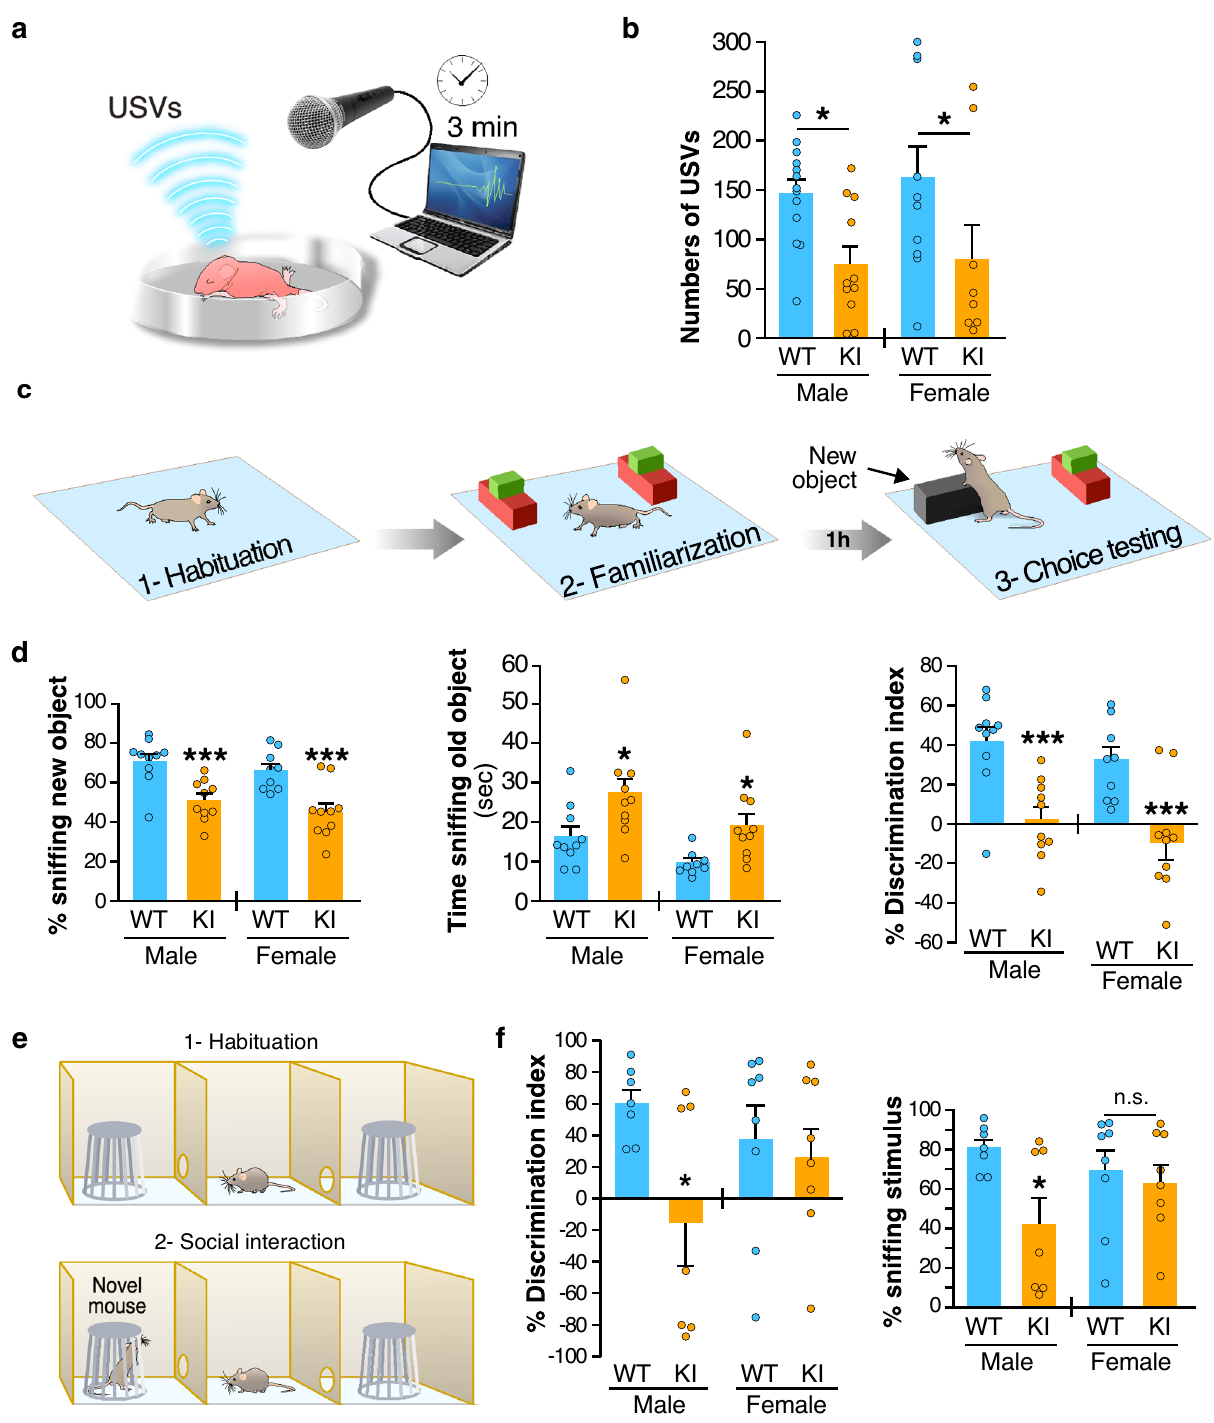
Fig. 6 Fmr1 R138Q mice show communication de fi cits and socio-cognitive alterations. a Schematic of the isolation-induced ultrasonic vocalizations (USVs) test. b Compared to WT animals, Fmr1 R138Q KI mice (PND7) emit ~50% less USVs when removed from the nest. Histogram shows the mean values ± s.e.m. of USVs in WT and Fmr1 R138Q males and females. WT, N = 13 males, 11 females; Fmr1 R138Q , N = 10 males, 8 females. * p = 0.028. c Schematic of the object recognition test used to assess the cognitive domain. d Quanti fi cation shows the mean values ± s.e.m. of time snif fi ng the new object (%), the old object (s), and the discrimination index (%) for both PND40 – 45 WT and Fmr1 R138Q males and females. WT, N = 10 males, 9 females; Fmr1 R138Q , N = 10 males, 10 females. * p = 0.011 (male), * p = 0.028 (female), *** p < 0.001. e Scheme of the three-chamber test used to assess sociability. f Histograms show the mean percentage ± s.e.m. of discrimination index and time snif fi ng the stimulus mouse for both PND40 – 45 WT and Fmr1 R138Q males and females. WT, N = 7 males, 8 females; Fmr1 R138Q , N = 7 males, 8 females. * p = 0.017. Two-way ANOVA with genotype and sex as factors followed by Newman – Keuls post-hoc test for individual group comparisons were computed for all behavioral studies. Source data are provided as a Source Data fi